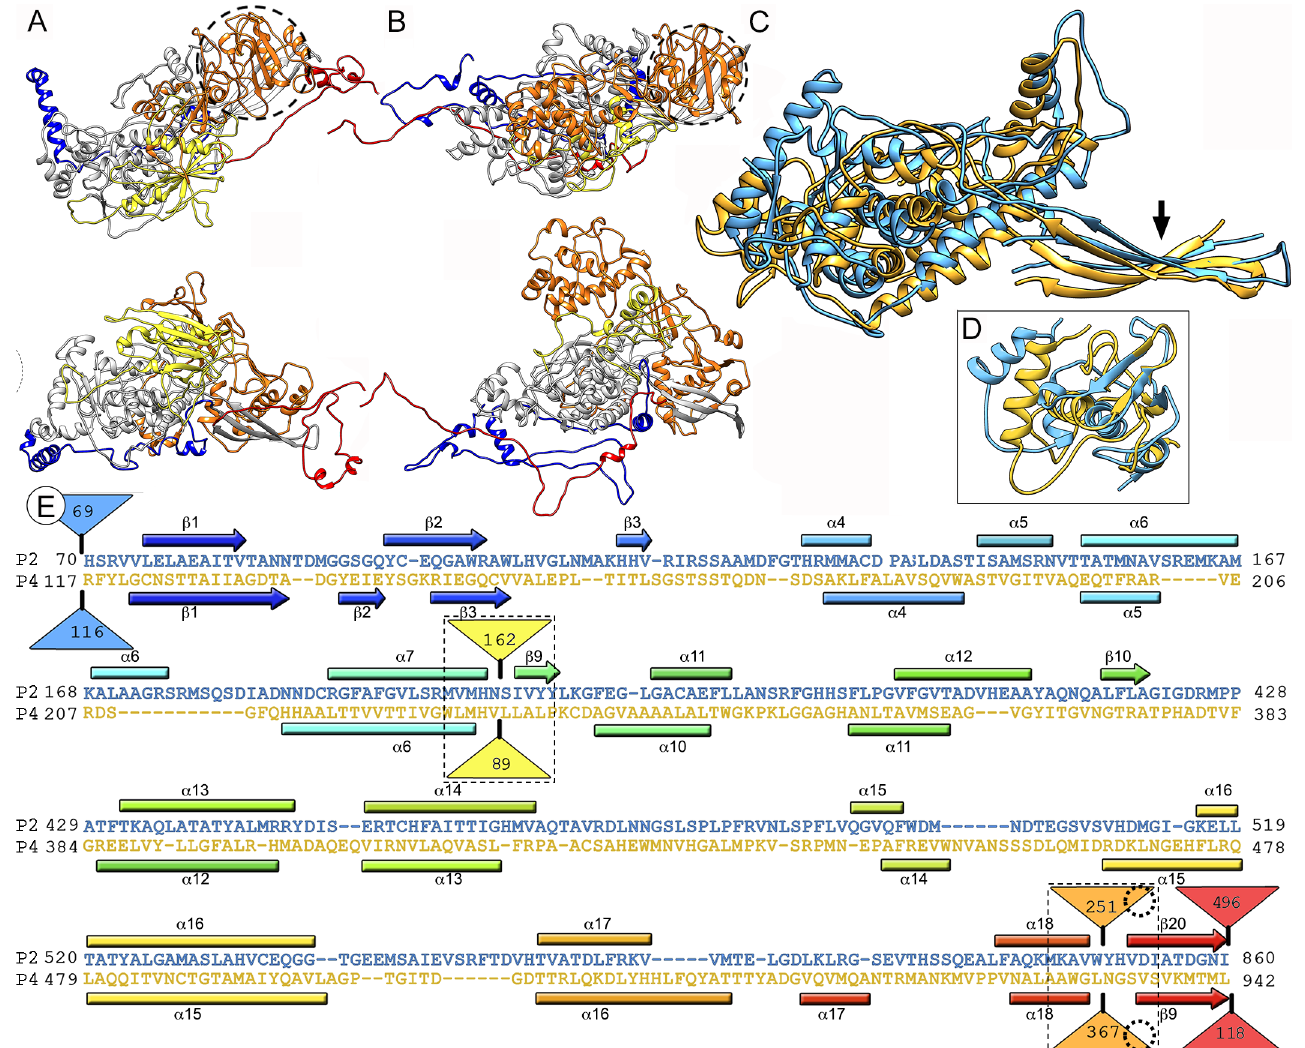
Fig 4. Structural similarities of P2 and P4 capsid proteins. (A, B) Atomic models of P2 (A, top view, top; side view, bottom) and P4 (B, top view, top; side view, bottom). Conserveddomainsare grey (SID of P2 and P4, or P2 * and P4 * ); insertions at the N terminus (blue), middle (yellowand orange),and C terminus (red) are also shown (the last 54 residues of P2 are omitted). Dashedcircles correspond to P2 and P4 SIID. (C) Superimposed P2 * (blue) and P4 * (yellow) (non-superimposableregions for both CP are omitted). Arrow indicatesshared β -sheet. (D) The P2 Cys738-Ser848 and the P4 Gly817-Thr929 segments (SIID of P2 and P4), includedin the middleinsertion(orange),are structurally aligned.(E) Sequence alignmentof P2 * (blue) and P4 * (yellow)resultingfrom Dali structural alignment. α -helices (rectangles) and β -strands (arrows) are rainbow-coloredfrom blue (N terminus) to red (C terminus) for each protein. Dashedrectanglesindicate favorable insertionsites, trianglesrepresent non-aligned segments(sizes indicated), and dashedcircles correspond to P2 and P4 SIID. Insertions in sites 1 and 2 are shown as yellow and